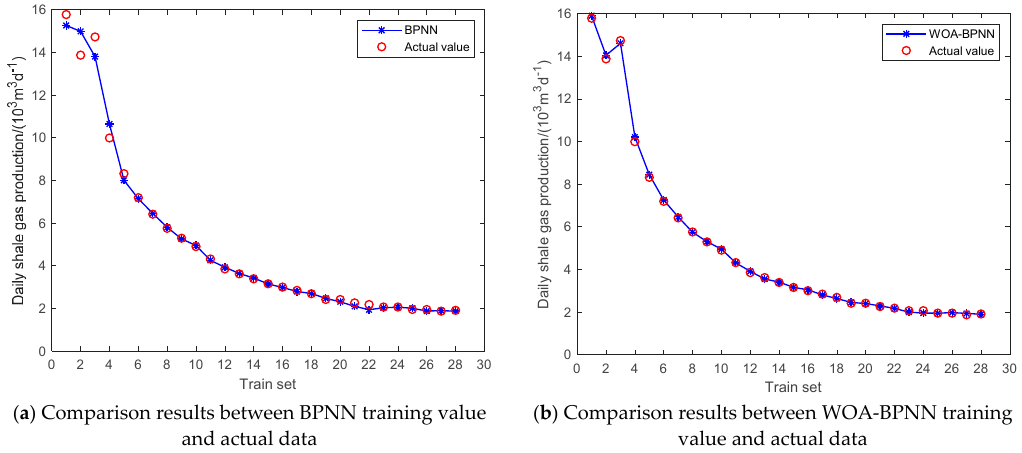
0 2 4 6 8 10 12 14 16 18 20 22 24 26 28 30 Train set